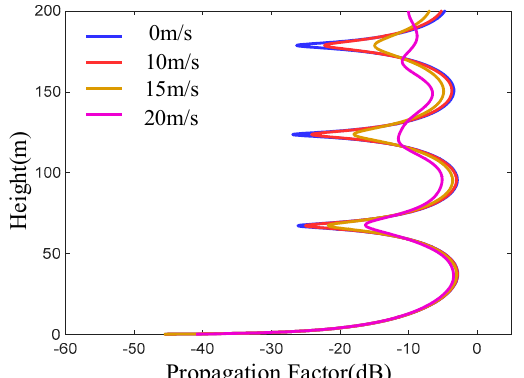
Figure 9. The curve of propagation factor varying with altitude at different roughness of sea surface at 13 km horizontal distance.